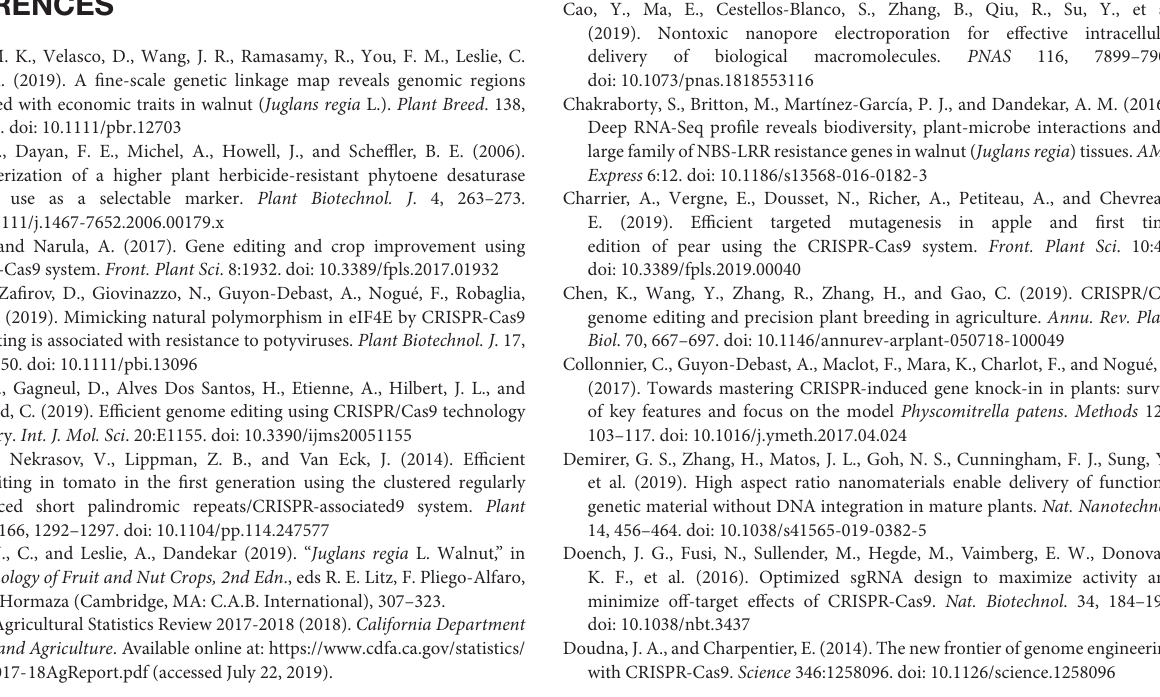
Table S1 | Complete list of retrieved gRNA sequences targeting Phytoene desaturase of Juglans regia